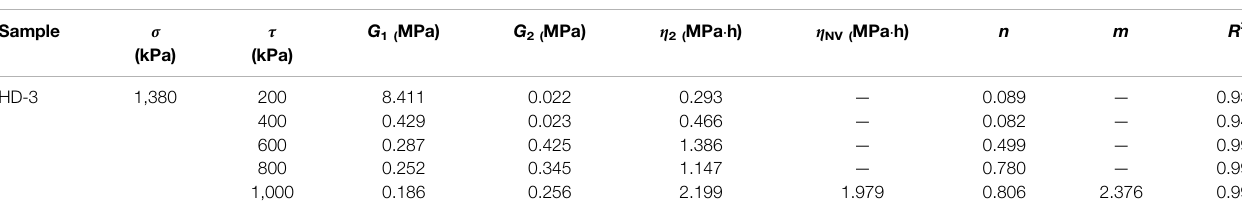
TABLE 3 | The fi tting parameter values of the NVPC model.